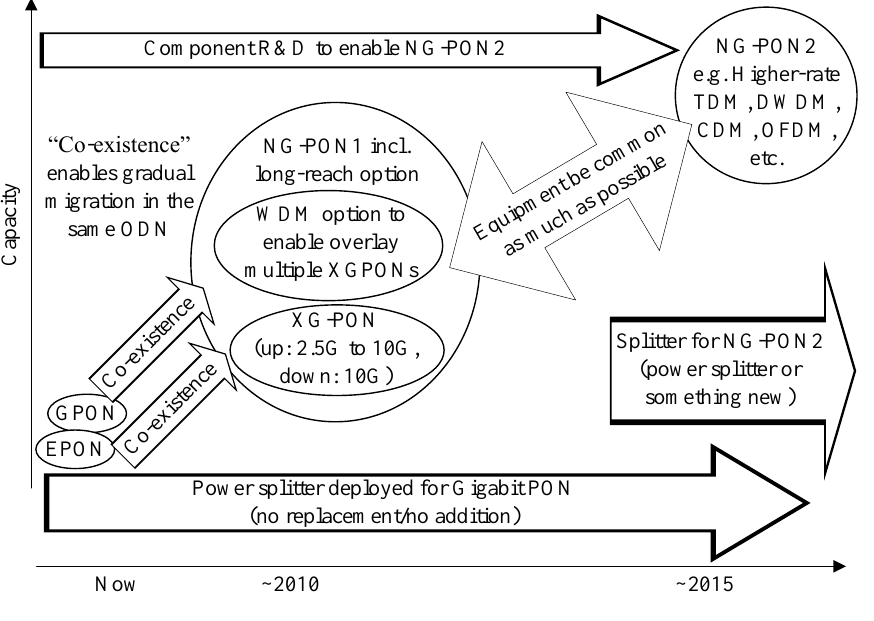
Figure 1. Next-generation passive optical network (NG-PON) roadmap as of 2009